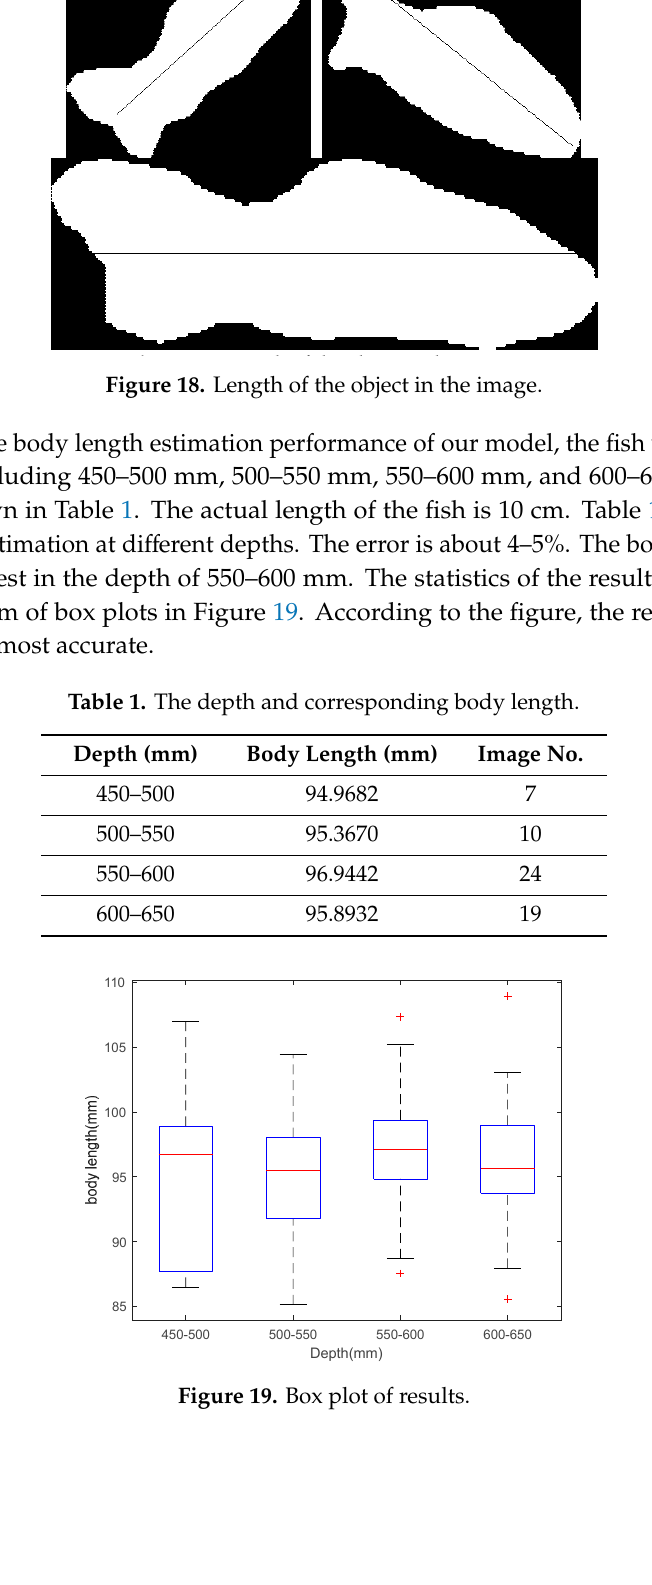
Figure 19. Box plot of results.